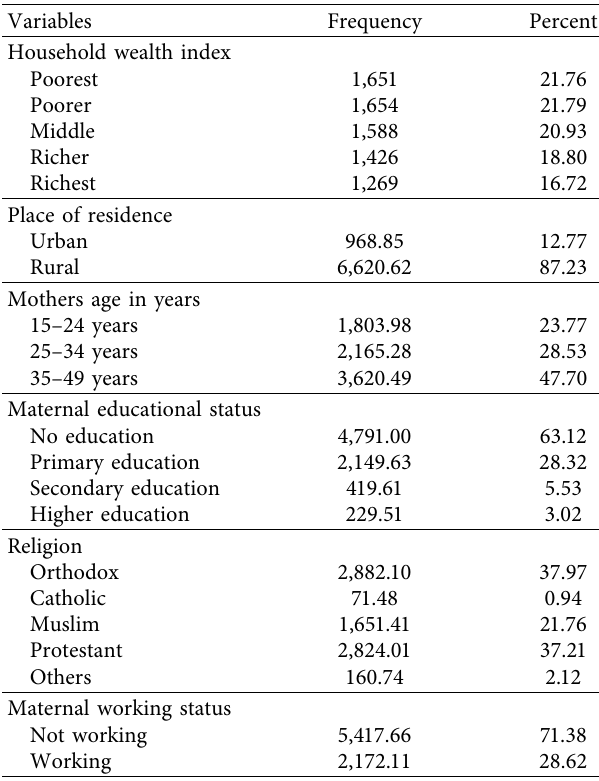
Table 1: Sample characteristics of women aged 15–49 who had their most recent live birth in the five years preceding the survey, 2016